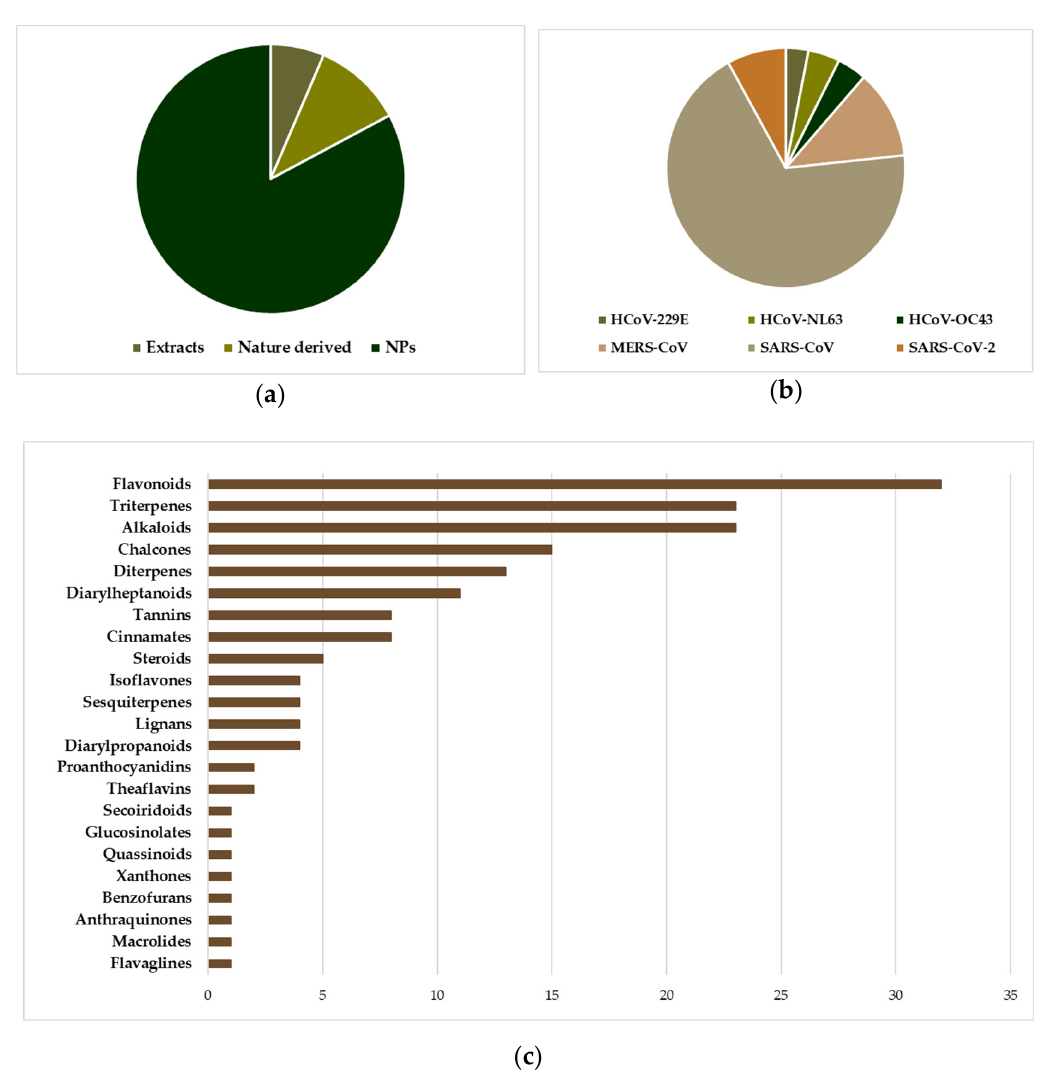
Figure 2. The position of natural products implicated in anti-HCoV research. ( a ) Distribution of entities (extracts, NPs, Nature derived molecules) subjected to anti-HCoV assays (cell based or viral enzyme inhibition), in a total of 326 experiments corresponding to 197 entities. “Nature derived” refers to synthetic/semisynthetic NPs with a basic core inspired by NPs. ( b ) The prevalence of SARS-CoV testing among several NP entities. ( c ) The distribution of the 168 pure NPs tested in various anti-HCoV assays, with respect to the chemical category. Data derived from Tables S1–S4, Supporting information. HCoV-229E uses human aminopeptidase N/CD13 glycoprotein (APN) to infect